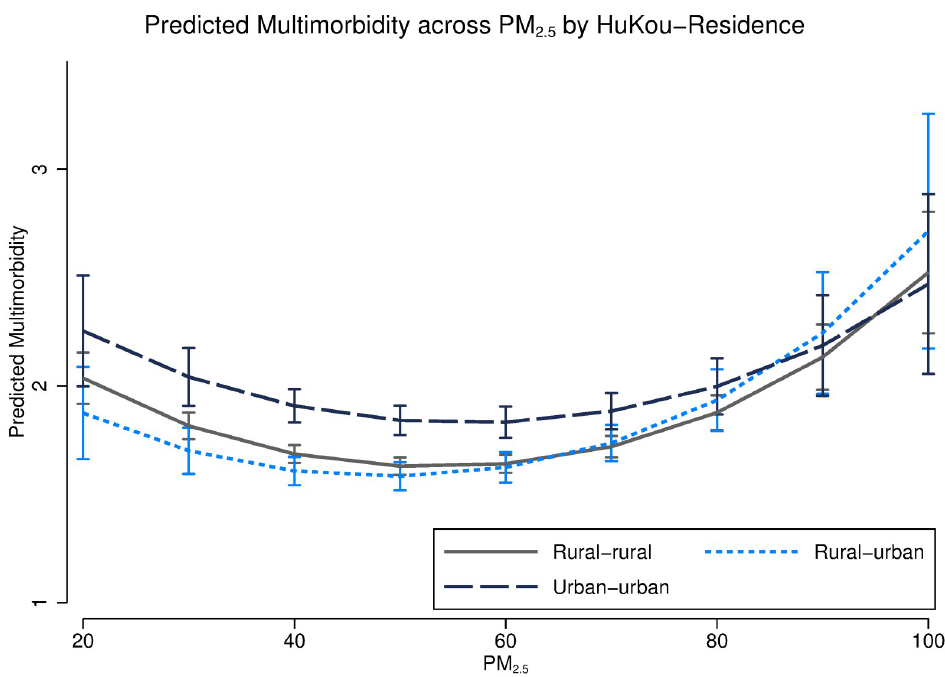
Fig 4. Predicted multimorbidity score across PM 2.5 exposure by HuKou-residence. Note that this model controls age, age squared, gender, education, HuKou-residence, occupations, marital status, smoking status and logged GDP.